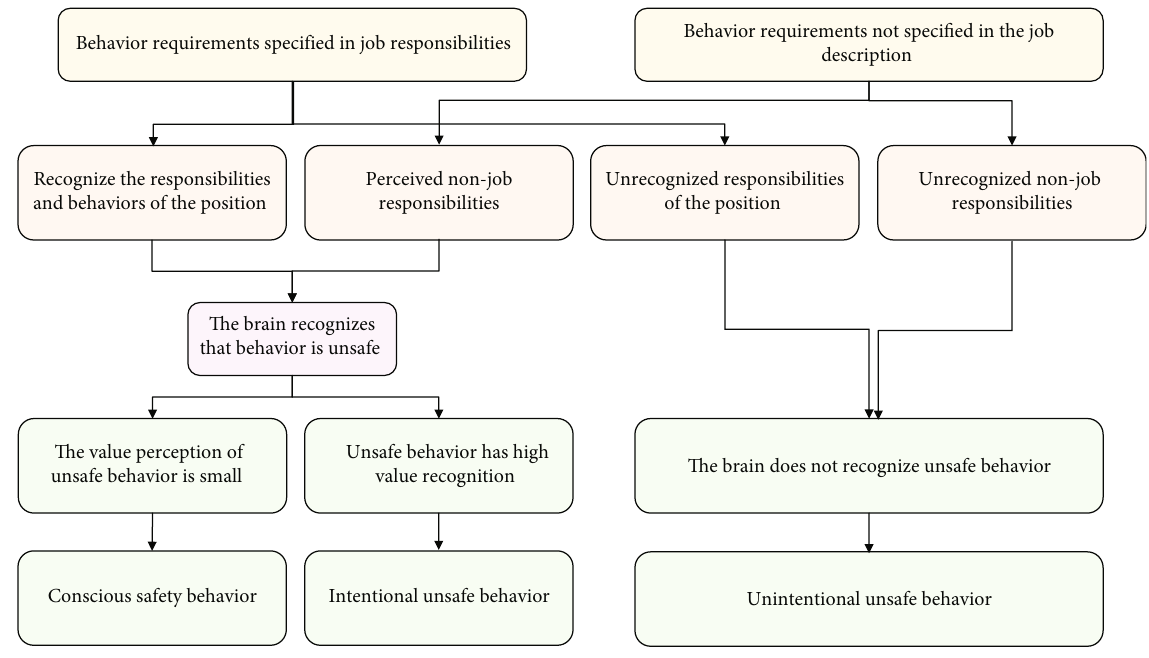
Figure 3: Development process of unsafe behavior in aging mine groups.